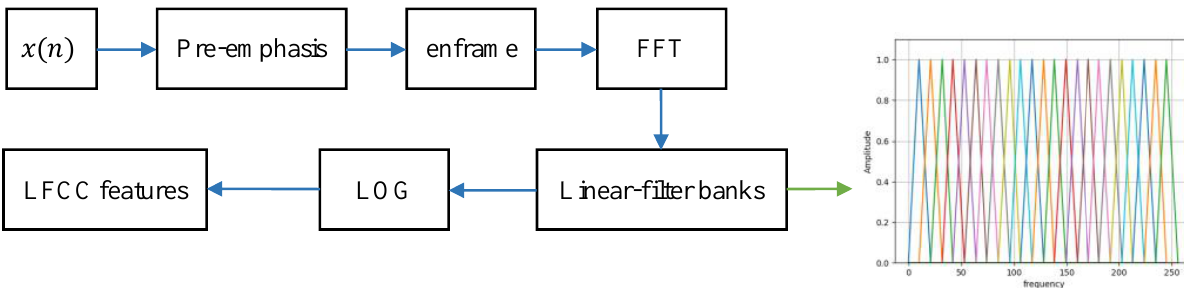
Figure 6. The extraction process of LFCC features.